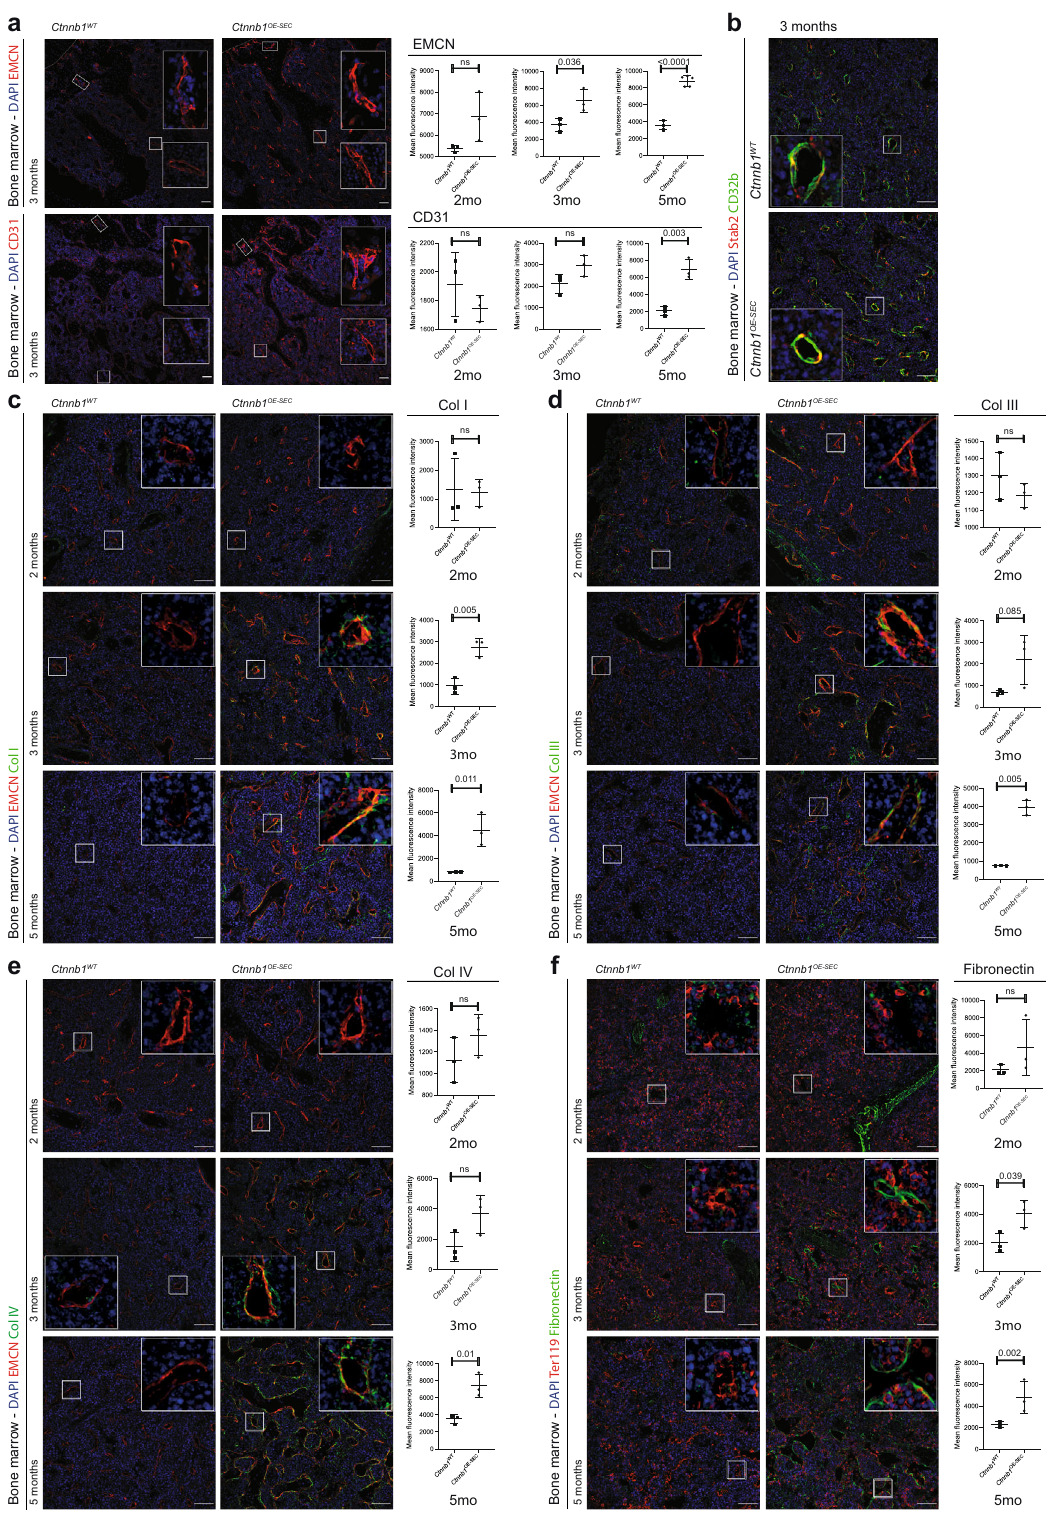
Fig. 4 BM-SEC in Ctnnb1 OE-SEC mice exhibit aberrant sinusoidal differentiation including increased extracellular matrix (ECM) deposition. a – f IF staining for endothelial, erythroid and ECM markers of Ctnnb1 WT and Ctnnb1 OE-SEC bone marrow sections of 2-, 3-, or 5-month-old female mice. Co-IF of DAPI, a CD31 and EMCN ( n = 3); b Stab2, CD32b ( n = 3); c EMCN, Collagen I (Col I) ( n = 3); d EMCN, Collagen III (Col III) ( n = 3); e EMCN, Collagen IV (Col IV) ( n = 3); and f Ter119, Fibronectin ( n = 3). Scale bars: 50 μ m. Quanti fi cations of IFs are shown next to corresponding IF staining ( a , c – f ). The dots in the graphs represent individual mice. Three representative images have been used for quanti fi cation per individual mouse. Mean ± s.e.m. is shown for each group of mice in all graphs. Statistical signi fi cance was determined using Student ’ s t -test or Mann – Whitney U test (two-sided). ns, not signi fi cant. Source data, and employed statistical tests for a , c , d , e , f are provided as a Source Data fi le.